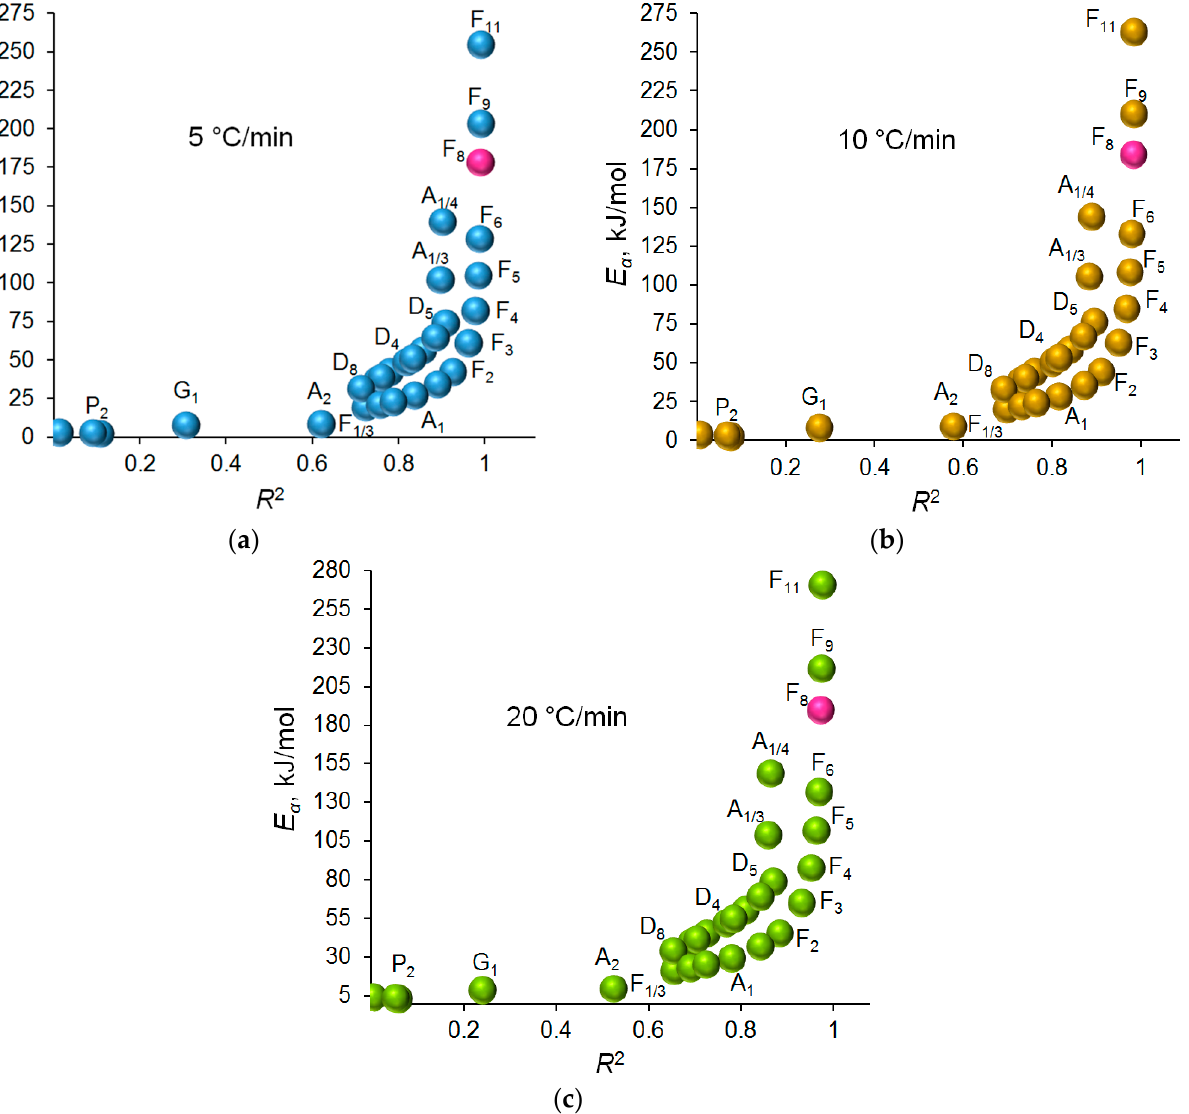
Figure 4. Diagrams of distributions of Е α and R 2 values for β : ( a ) 5 °C/min, ( b ) 10 °C/min, ( c ) 20 °C/min.